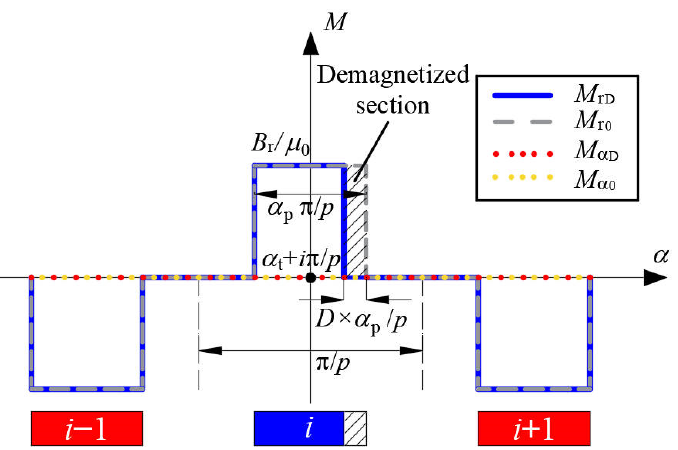
Figure 6. Magnetization of healthy PMs and partially demagnetized PMs (radial magnetization).